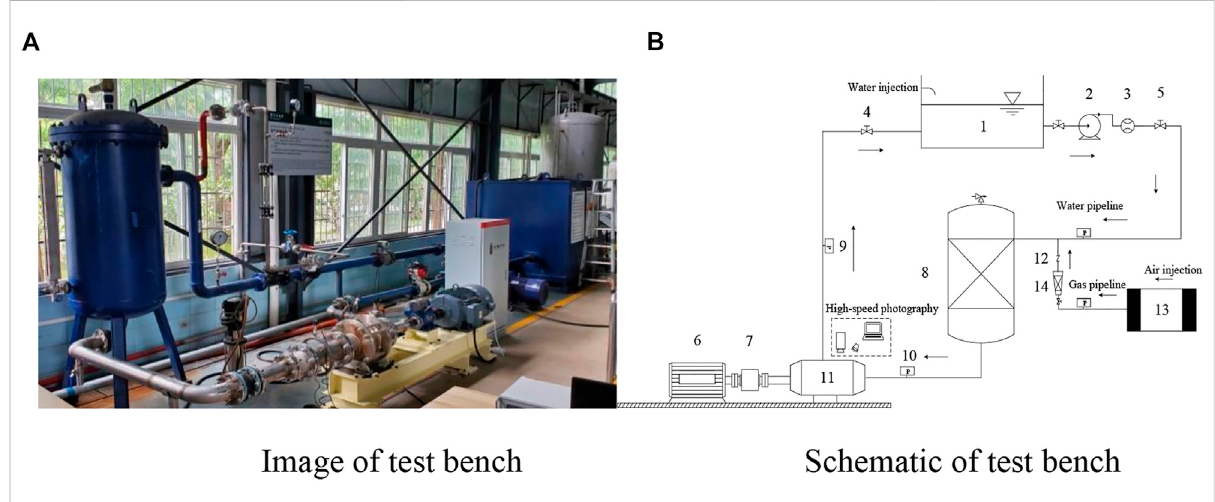
FIGURE 5 Experimental system. (A) Image of test bench. (B) Schematic of test bench.